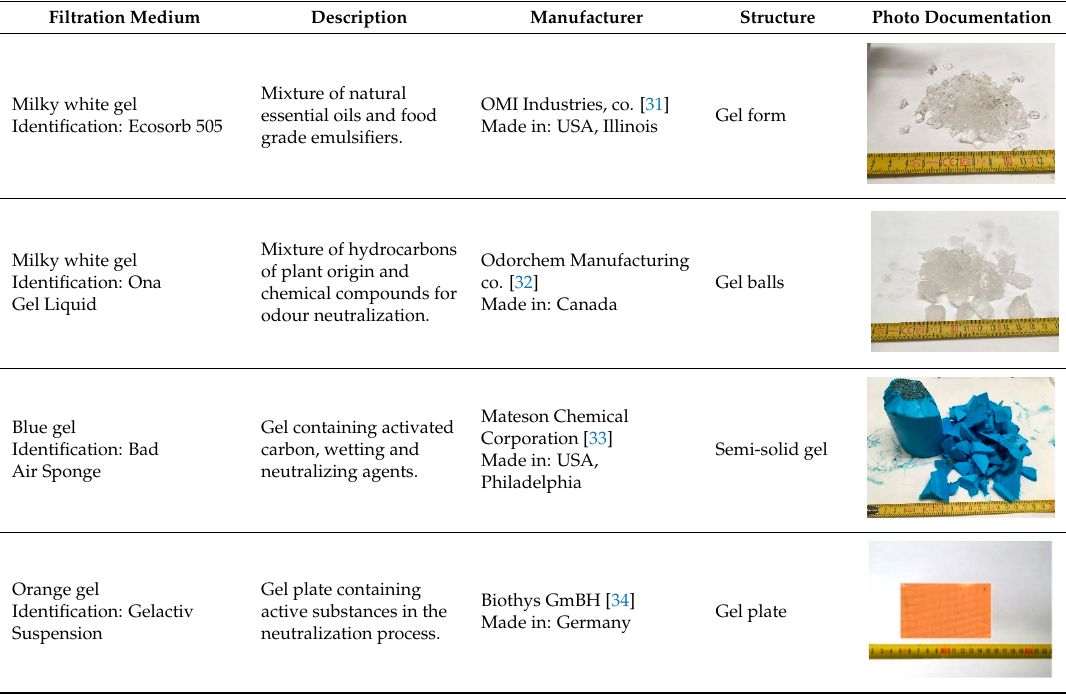
Table 5. Selected filter medium gels.